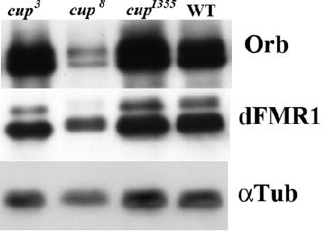
Figure 3. Orb protein levels are altered in cup mutant ovaries. A Western blot of ovary extracts from wild type and cup mutants as indicated was probed sequentially with Orb, dFMR1 and a -tubulin antibodies. Orb protein levels are reduced in cup 8 ovaries compared to wild type. The ratio of cup 8 / WT is 0.56 using dFMR1 as a loading control and 0.34 using a -tubulin as a loading control. In contrast, Orb levels are elevated in cup 3 and cup 1355 ovaries. For cup 3 , the level of Orb protein is elevated 1.8-fold using dFMR1 as a loading control and 1.9 using a - tubulin as the loading control. For cup 1355 , the level of Orb protein is elevated 1.6-fold using dFMR1 as a loading control, and 2.2-fold using a -tubulin as the loading control. Even larger increases were observed in another experiment: cup 3 : 3.0-fold using dFMR1 as the loading control and 2.25-fold using a -tubulin; cup 1355 : 2.9-fold using dFMR1 as the loading control and 2.8-fold using a -tubulin as the loading